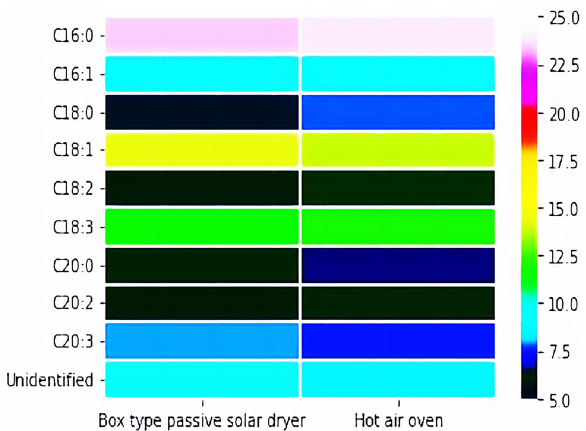
Figure 7. Heat map plotting of fold change ratio of fatty acids under BTPSD and hot air oven